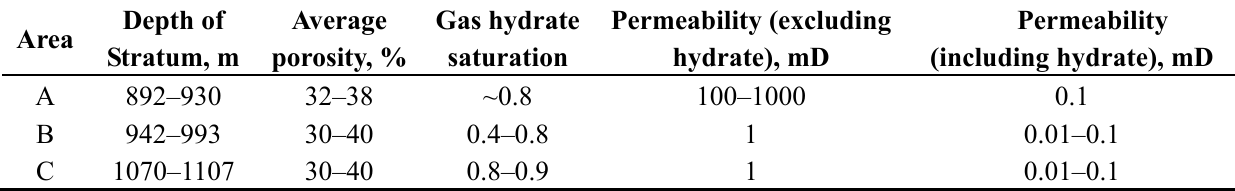
Table 5. Physical parameters of the Mallik 2002 hydrate reservoir